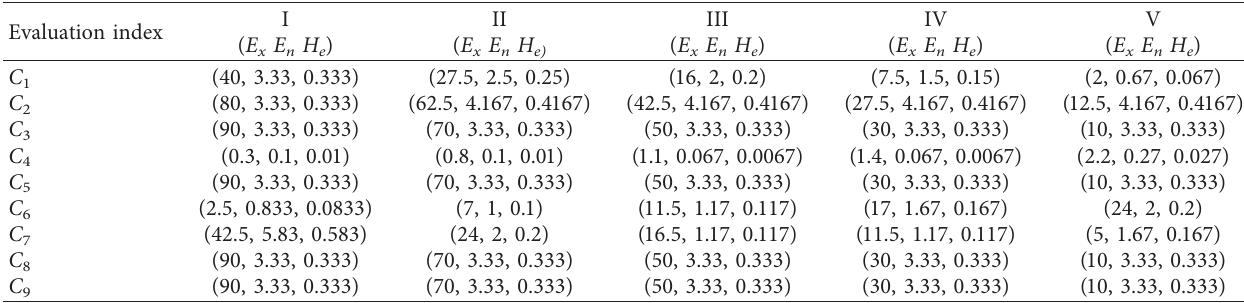
Table 2: Numerical characteristics of risk level for assessment index.